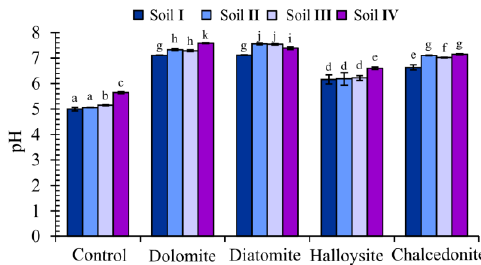
Figure 7. Results of soil pH obtained for the tested amendments; (mean ± SD, n = 3). Values in columns marked with the same letter do not differ significantly (Dunkan test, p > 0.05).